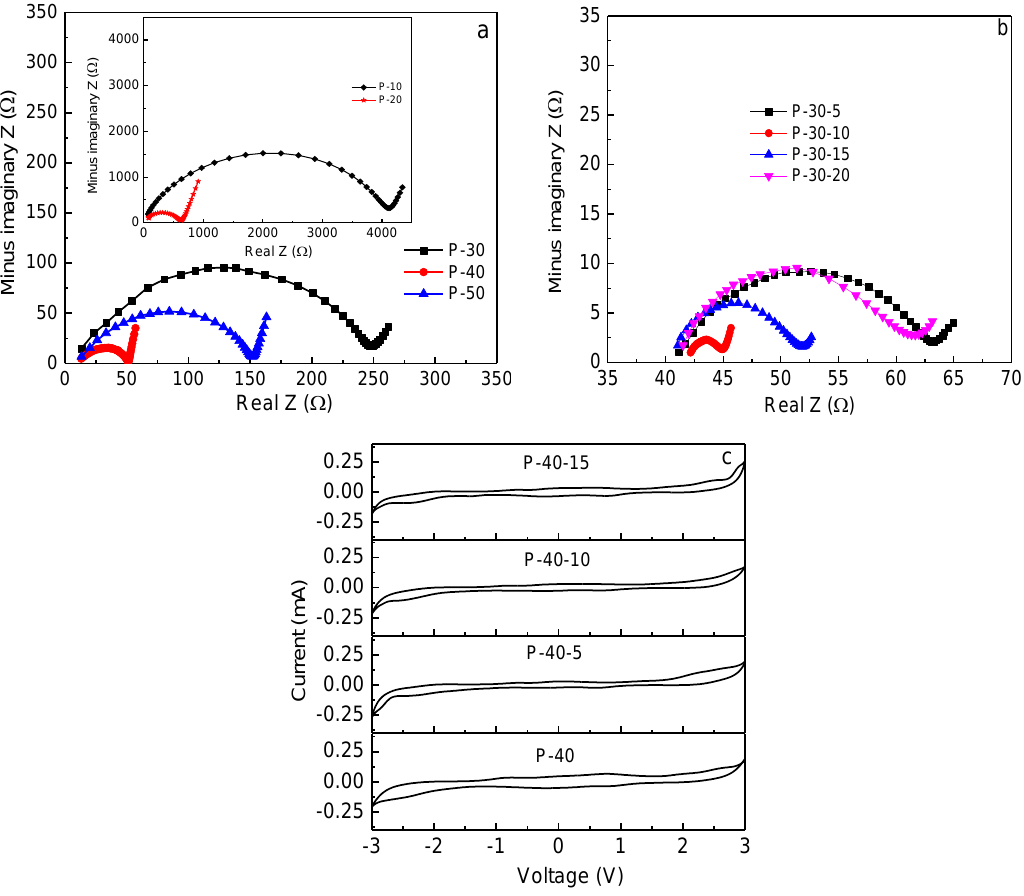
Figure 6. Nyquist impedance plots of ( a ) P-10, P-20, P-30, P-40, and P-50 films; and ( b ) P-40-5, P-40-10, P-40-15, and P-40-20 films. ( c ) Cyclic voltammograms for P-40, P-40-5, P-40-10, and P-40-15 films.